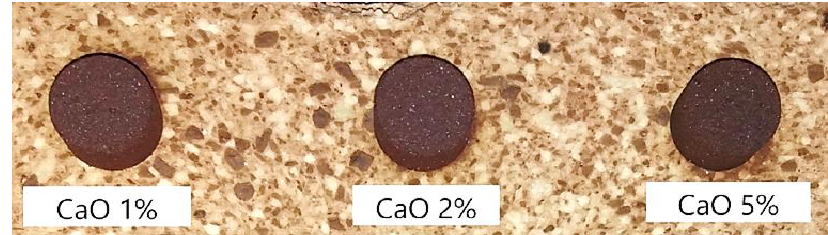
Figure 9. Peridotite sample E6743 without additives after calcination.